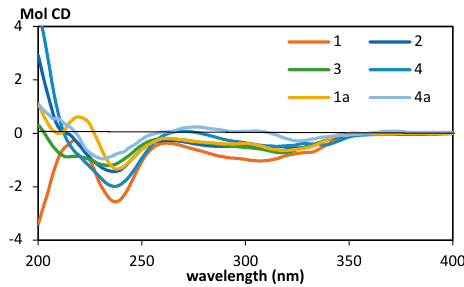
Figure 2. Electronic circular dichroism (ECD) spectra of 1 – 4 , 1a, and 4a .